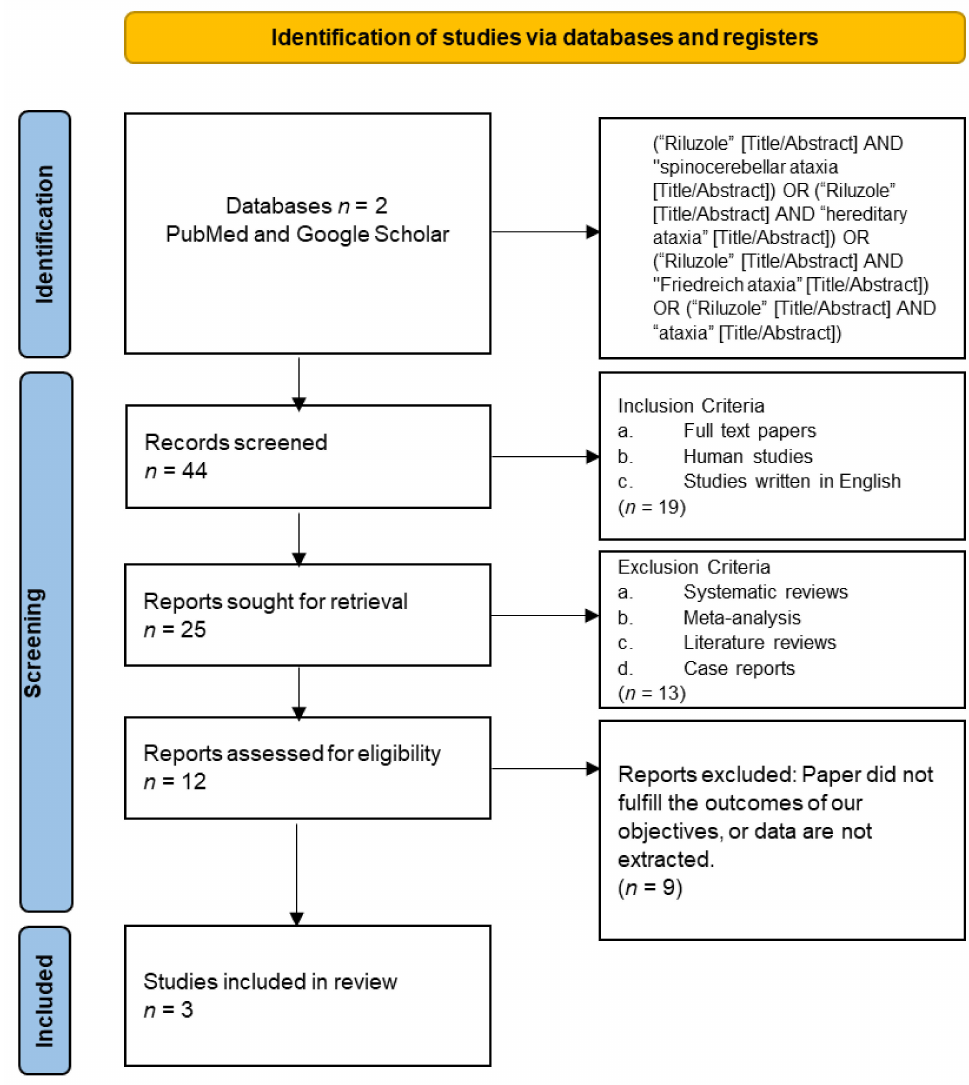
Figure 1. PRISMA flow chart used for this systematic